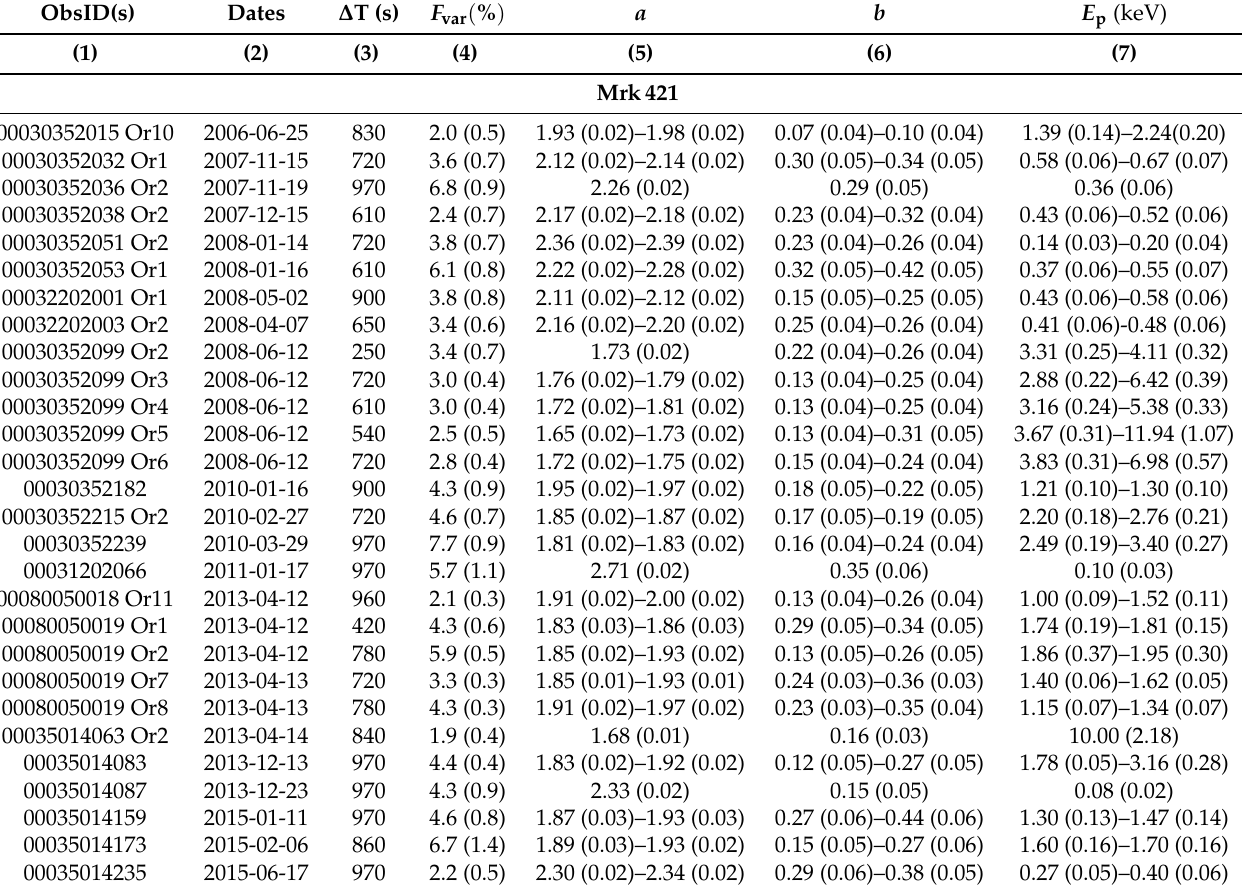
Table 1. Summary of the 0.3–10 keV sub-hour intra-day variabilities (IDVs) observed in bright high-energy peaked BL Lacertae sources (HBLs) on timescales shorter than 1 ks with Swift-XRT. In Column (1), “Or” stands for “Orbit”. The third column gives the duration of the particular observation (in seconds); Columns (5)–(7) give the ranges of the photon index, the curvature parameter and the position of the synchrotron spectral energy distribution (SED)